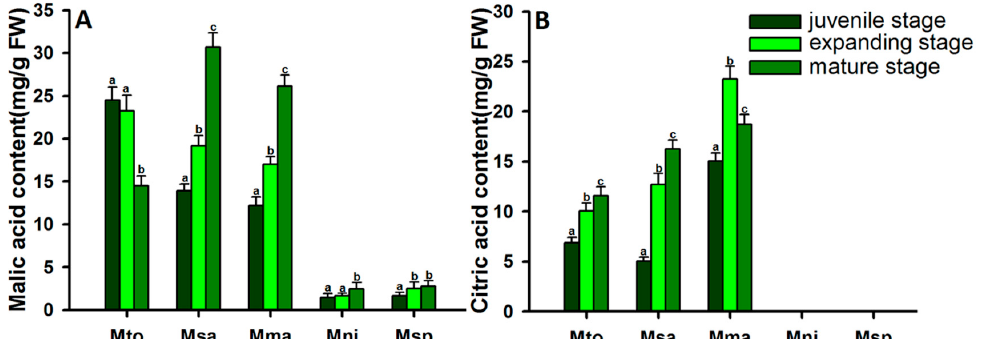
Figure 3. Changes in malic acid and citric acid content in fruits of different apple accessions during fruit development. ( A ): The accumulation pattern of malic acid in fruits of different apple accessions during fruit development. ( B ): The accumulation pattern of citric acid in fruits of different apple